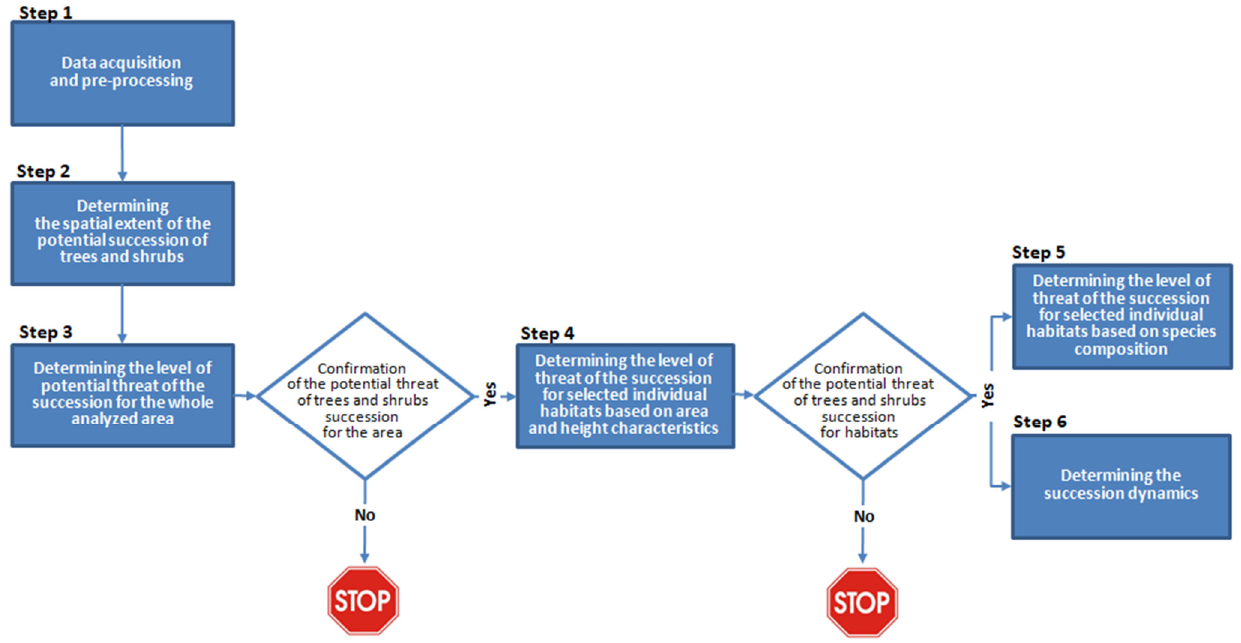
Figure 2. Methodology scheme.